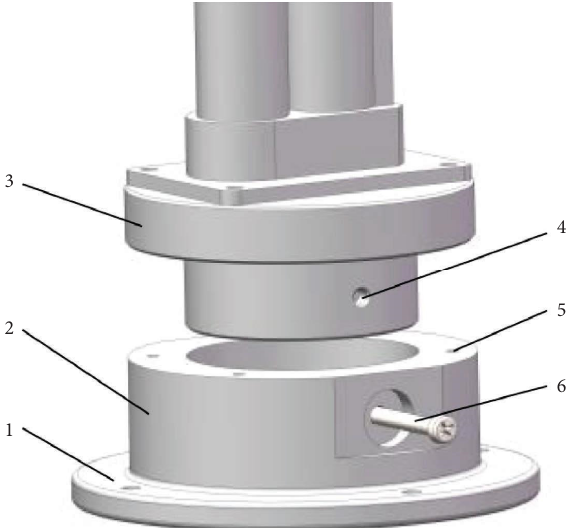
Figure 5: Quick release mechanism. (1) Base. (2) Lower connecting body. (3) Upper connecting body. (4) Pin hole. (5) Positioning hole. (6) Reset